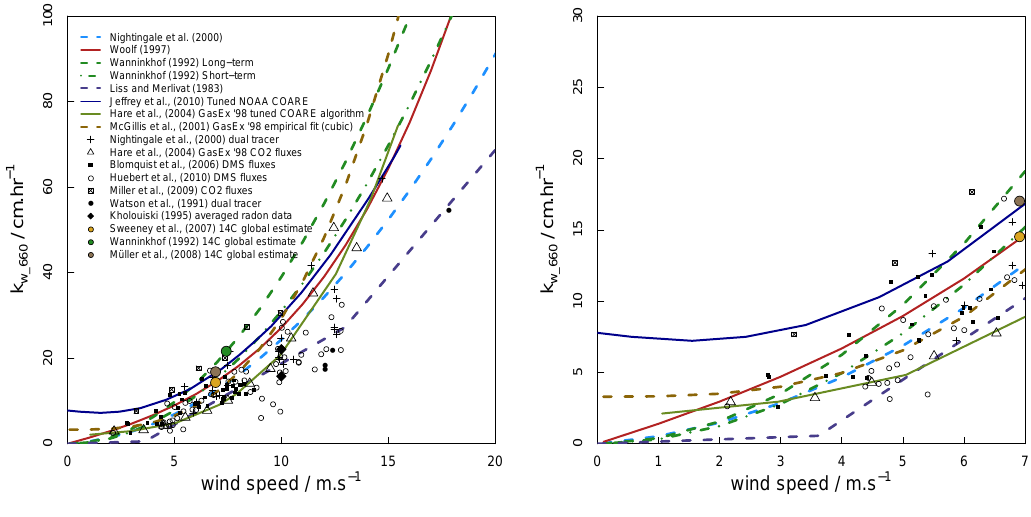
Fig. 5. Comparison of various observations, parameterizations and tuned model predictions of the increase with wind speed of the liquid phase transfer velocity ( k w ) scaled to a Schmidt number of